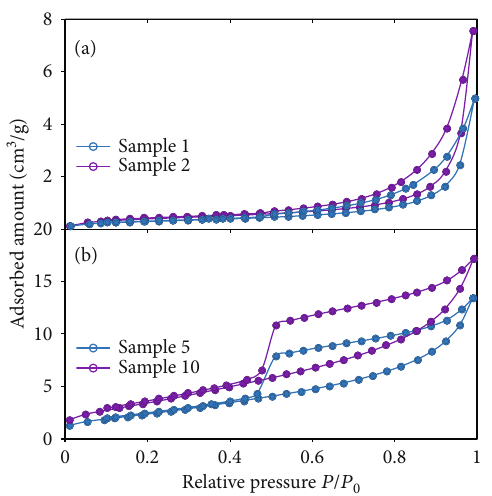
Figure 7: Typical nitrogen isotherms of the shale samples for qn K 2 1